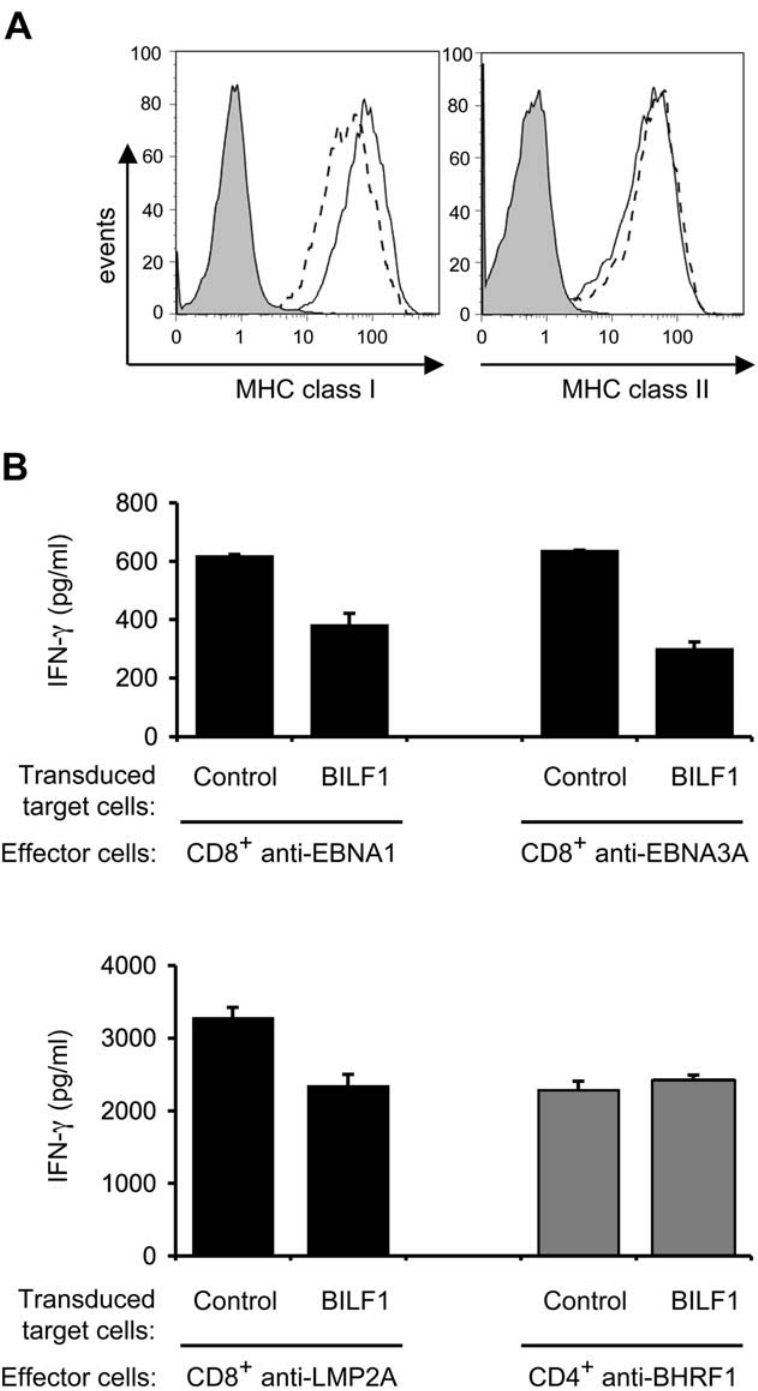
Figure 4. BILF1 downregulates surface MHC class I expression and inhibits the T cell recognition of endogenous EBV antigen in LCLs. ( A ) LCLs were transduced with PLZRS-HABILF1-IRES-GFP retrovirus. After 6 days, surface MHC class I was stained with PE-conjugated W6/32 mAb and MHC class II was stained with PE-conjugated anti-DR mAb, YE2/36-HLK. Two-colour flow cytometry was used to analyze staining in the untransduced, GFP 2 , population, shown as the solid line histogram, and in the transduced GFP + (BILF1 + ) population, shown as the dashed line histogram. The grey histogram denotes background staining obtained with an isotype control PE-conjugated antibody. ( B ) LCL cultures transduced with control retrovirus or with the BILF1 retrovirus were sorted by flow cytometry to generate GFP + /BILF1 2 and GFP + /BILF1 + lines to use as targets in assays with EBV-specific T cells. The control and BILF1 + LCL targets were incubated with HLA-matched CD8 + effector T cells clones specific for EBNA1 (HPV), EBNA3A (YPL), or LMP2A (CLG) peptides, or a CD4 + effector T cell clone specific for a BHRF1 (PYY) peptide. After 18 hrs the supernatants were tested for the release of IFN- c as a measure of T cell recognition. All results are expressed as IFN- c release in pg/ml and error bars indicate standard deviation of triplicate cultures.